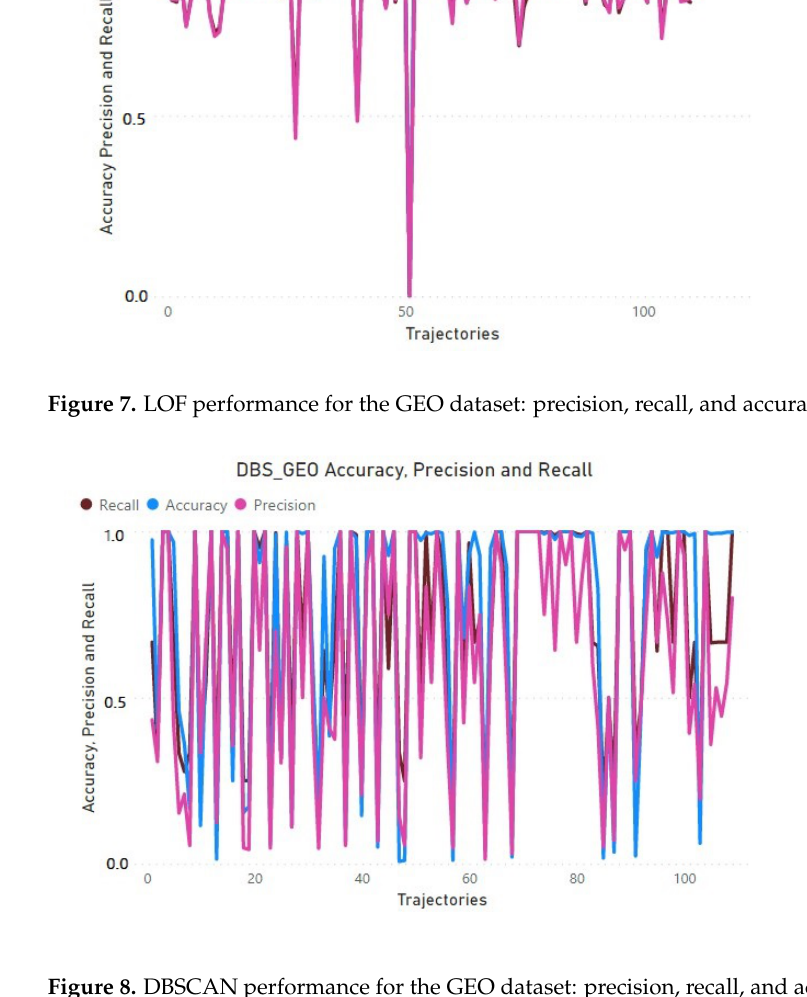
Figure 8. DBSCAN performance for the GEO dataset: precision, recall, and